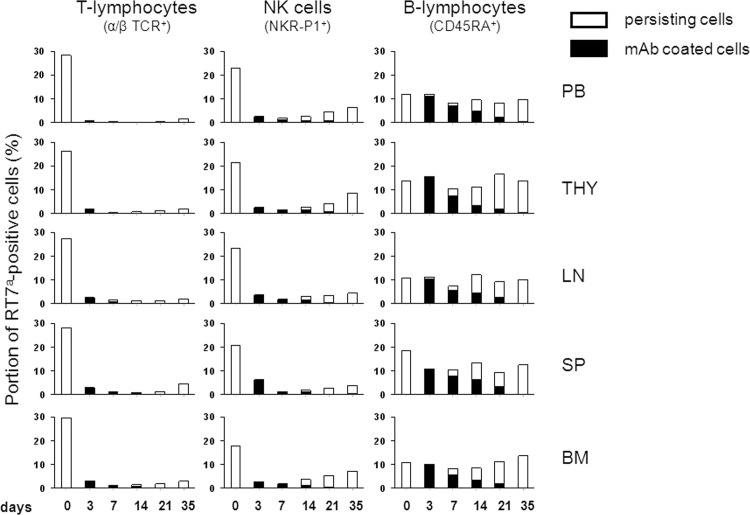
Biodistribution and effects of biotinylated anti-RT7a mAb in lympho-hematopoietic compartments of RT7a/RT7b chimeras.To enable reliable flowcytometric gating of lymphocyte subsets, which will be strongly depleted by the anti-RT7a mAb, six mixed chimeras carrying disparity only in the RT7 (CD45) antigen were generated by sublethal TBI of 7 Gy. Reconstituted rats showed a multi-lineage RT7a-chimerism of 10 to 30 percent differing between lineages and compartments (day 0 = before mAb application). The biotinylated anti-RT7a mAb was applied once (2 mg/kg) before the tissue compartments were analysed by flow cytometry at days 3, 7, 14, 21 and 35. The fraction of persisting RT7a positive cells is given as percentage of all CD45+ cells per lineage (column height). The black column gives the fraction of RT7a positive cells that is coated by the biotinylated anti-RT7a mAb. T-lymphocytes (α/βTCR+) and NK cells (NKR-P1+) were strongly and compartment independently depleted, whereas B-lymphocytes (CD45RA+) were coated by anti-RT7a mAb, but were not significantly reduced in cell number despite high-graded coating. (PB–peripheral blood, THY–thymus, LN–lymph node, SP–spleen, BM–bone marrow).